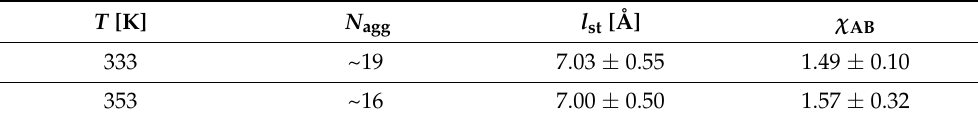
Table 3. Fit Parameters obtained using the generalized RPA model at T = 333 K to PEG-thy/dat SAXS data